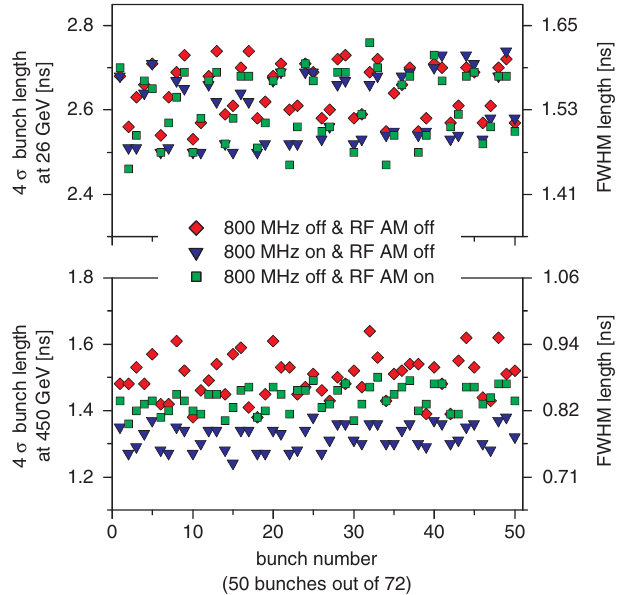
FIG. 11. (Color) Bunch lengths measured at FB and at